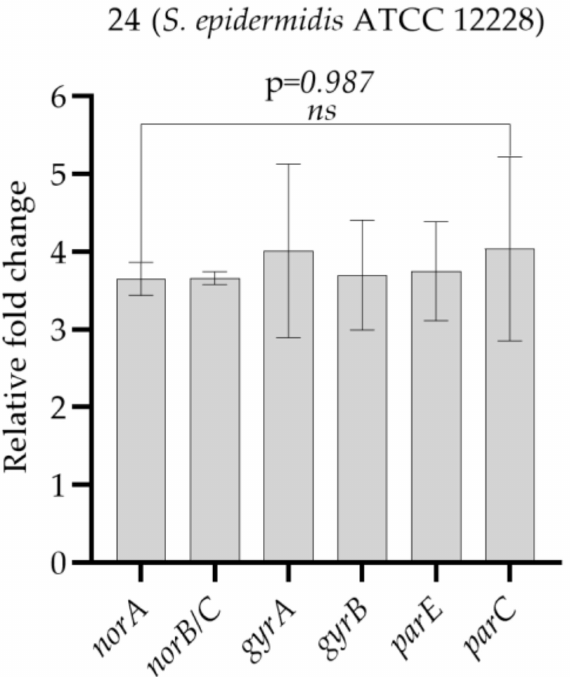
Figure 3. Comparison of gene expression values of strain 24 ( S. epidermidis ATCC 12228), which developed resistance to ciprofloxacin after 30 days of exposure to aluminum chlorohydrate, and control bacterium that developed resistance to ciprofloxacin following subculturing only in LB broth without aluminum chlorohydrate for 30 days. ns : not significant. One-way ANOVA was used to compare the means of the groups. Tukey’s post hoc test was performed to make pairwise comparisons. Bars represent standard